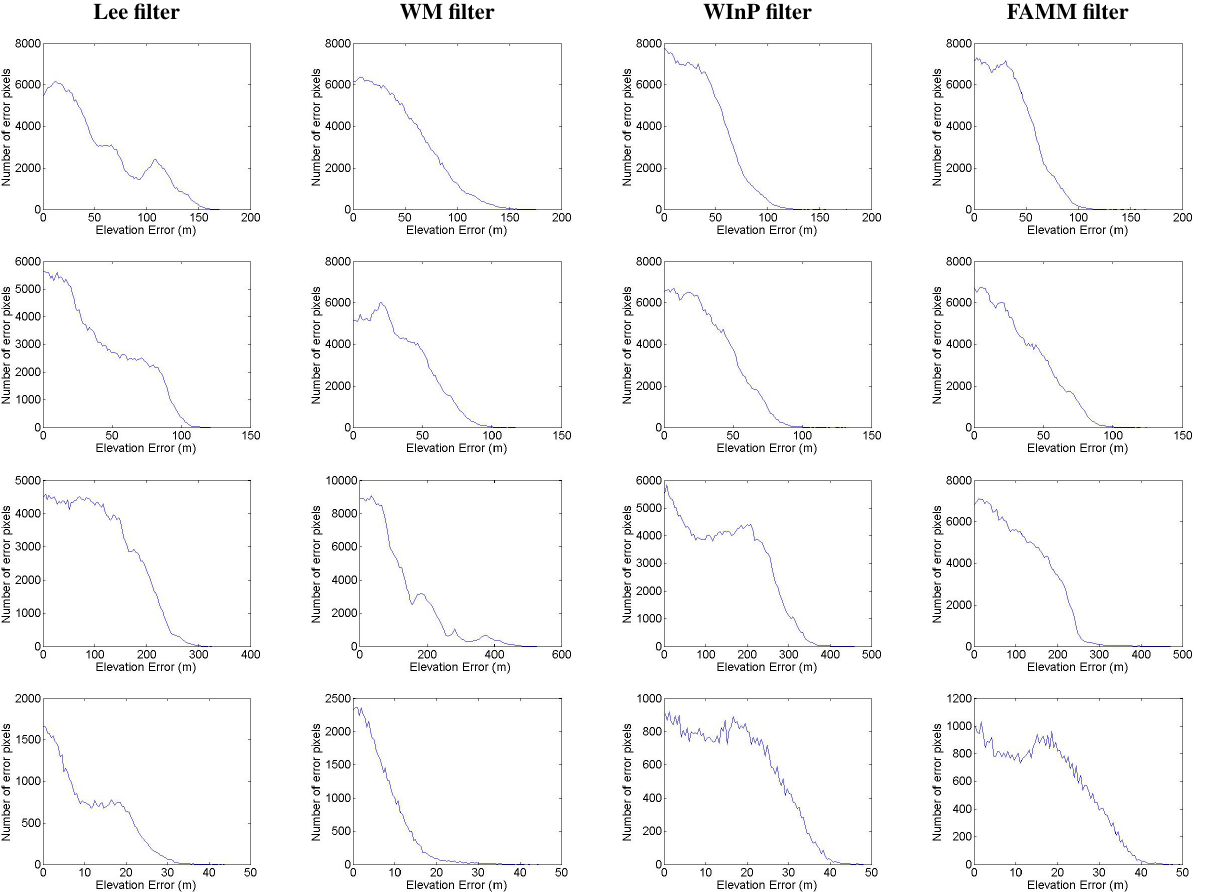
Figure 2: The distribution histogram of the elevation error between the DEM provided from ASTER satellite and the DEM produced from the filtered unwrapped phase of Radarsat-2 (first row), Envisat (second row), ERS-2 (third row) and COSMO-SkyMed (fourth